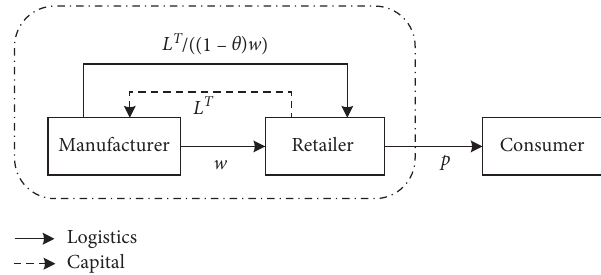
Figure 2: Supply chain operation and financing process under trade credit financing